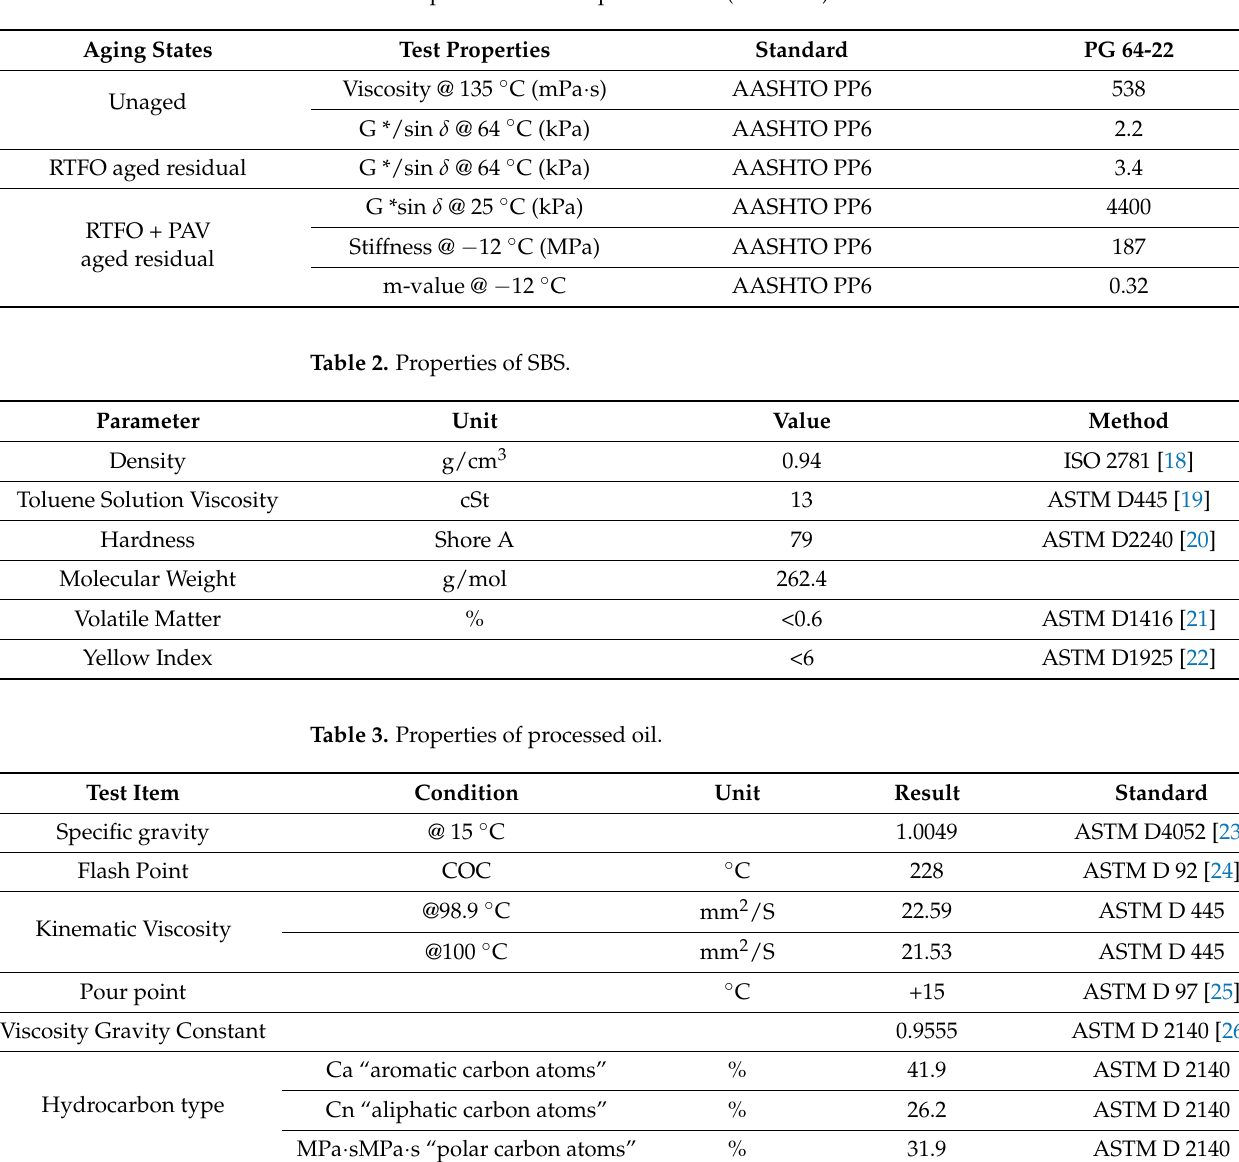
Table 1. Properties of base asphalt binder (PG 64-22).